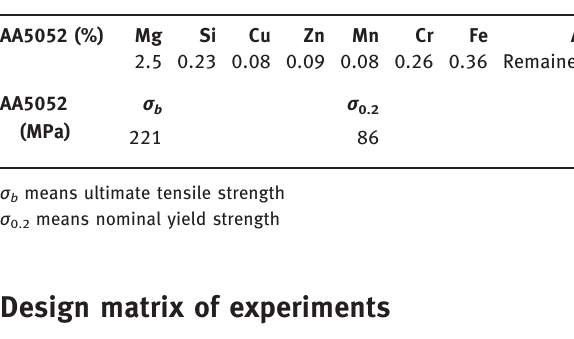
Table 1: Chemical composition and mechanical properties of AA5052.